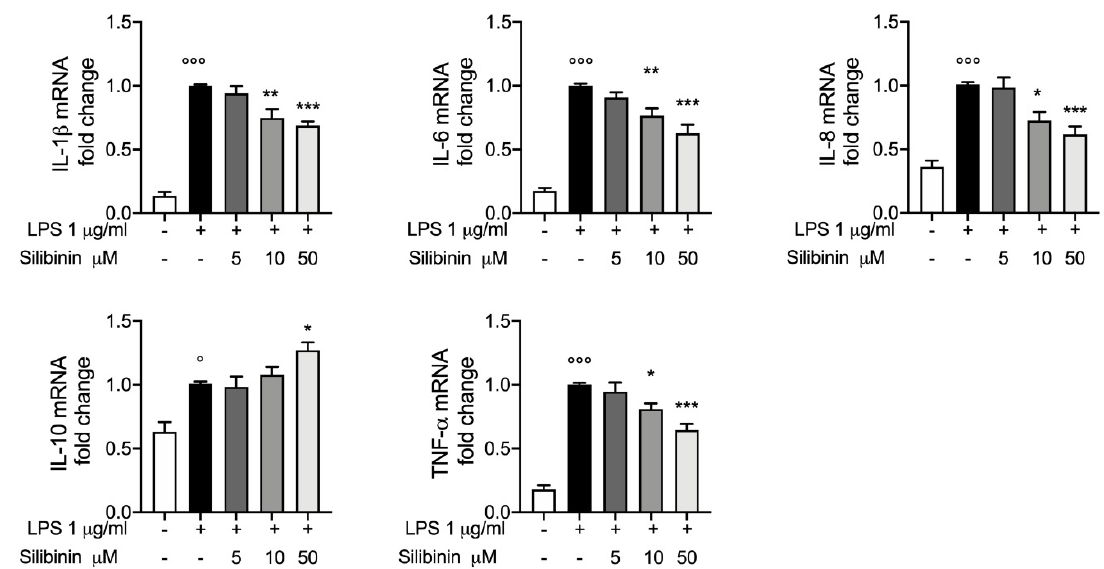
Figure 2. Silibinin effect on mRNA cytokines expressions RT-PCR assay for mRNA of IL-1 β , IL-6, IL-8, IL-10 and TNF- α , levels express as mRNA fold change in equine PBMCs treated or not with silibinin 5 μ M, 10 μ M and 50 μ M for one hour, before stimulation with LPS 1 μ g/mL for four hours. Data are representative of at least three experiments, means ± SEM; ° p < 0.05 vs. control; °°° p < 0.001 vs. control; * p < 0.05 vs. LPS; ** p < 0.01 vs. LPS; *** p < 0.001 vs. LPS; − absent; + present.